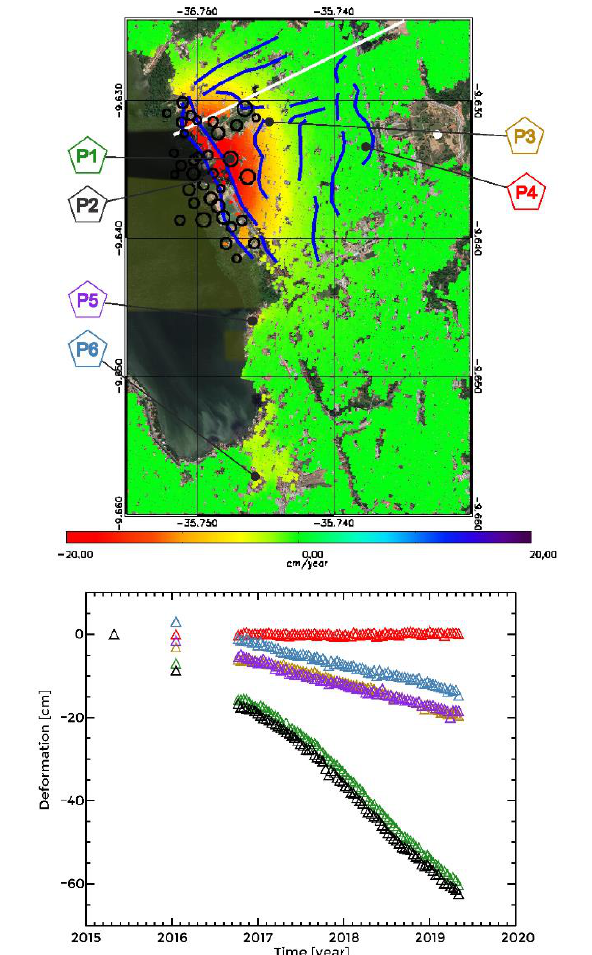
Figure 2. Mean velocity of deformation (top) and time series extracted at selected locations (bottom). Note that the first data in the time series is common for all of them, i.e. is the common origin for the displacements. White dot in the velocity map marks the location of the reference stable point. Black circles indicates the location of salt mining facilities (see discussion). Blue lines mark surface intersection of normal